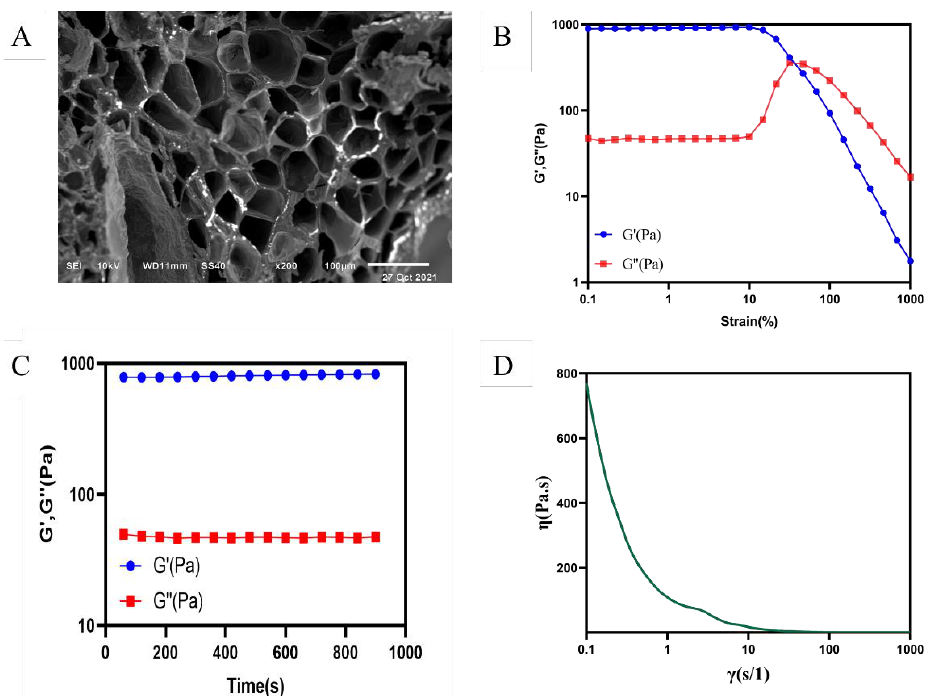
Figure 5. SEM and rheological properties of hydrogel. ( A ) SEM morphology of hydrogel. Rheological measurements of the hydrogel. ( B ) Strain amplitude sweep test of hydrogel with a constant frequency of 10 rads − 1 and a varying of the strain from 0.1% to 1000%. ( C ) Dynamic time sweep of the hydrogel, at a strain of 1%. ( D ) Viscosity curve of hydrogel. The concentration of the hydrogel was 40 mg mL − 1 (17.6 mM), T = 25 °C.